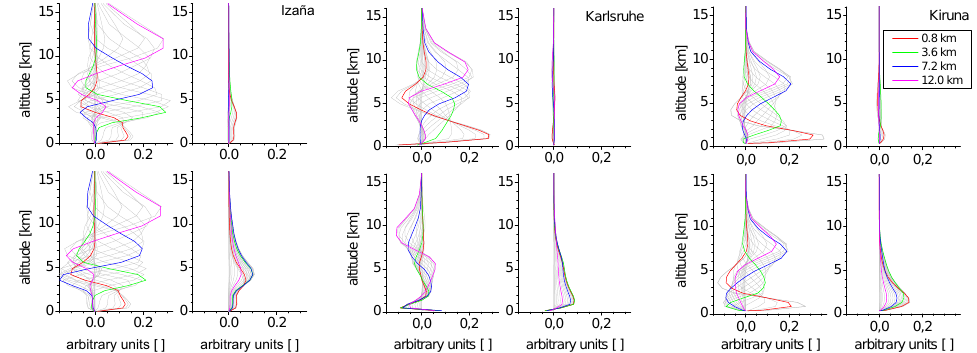
Figure 1. Example of IASI row kernels in the {ln[H 2 O], ln[HDO]}-basis (kernel matrix A ). There are three groups of graphs: left group for Izaña, central group for Karlsruhe, and right group for Kiruna. The upper panels display how the retrieved ln[H 2 O] is affected by actual Fig. 1. Example of IASI row kernels in the { ln[H 2 O], ln[HDO] } -basis (kernel matrix A ). There are three groups of graphs: left group for Iza˜na, central group for Karlsruhe, and right group for Kiruna. The upper panels display how the retrieved ln[H 2 O] is affected by actual ln[H 2 O] variations (left panel of each group) and by actual ln[HDO] variations (right panel of each group). The lower panels display the ln[H 2 O] variations (left panel of each group) and by actual ln[HDO] variations (right panel of each group). The lower panels display the same for the retrieved ln[HDO]. Wiegele et al.: The MUSICA MetOp/IASI H 2 O and δ D products same for the retrieved ln[HDO]. Kiruna. Each group consists of four graphs: the top left and 270 bottom right graphs show how atmospheric ln[H 2 O] vari- ations affect the retrieved { ln[H 2 O] } -state and how atmo- spheric ln[HDO] variations affect the retrieved { ln[HDO] } - state, respectively. Furthermore, there are large cross de- pendencies (top right and bottom left graphs) that have to 275 be considered. They show how atmospheric ln[HDO] vari- ations affect the retrieved { ln[H 2 O] } -state and how atmo- spheric ln[H 2 O] variations affect the retrieved { ln[HDO] } - state. Due to this cross dependencies and due to the fact that